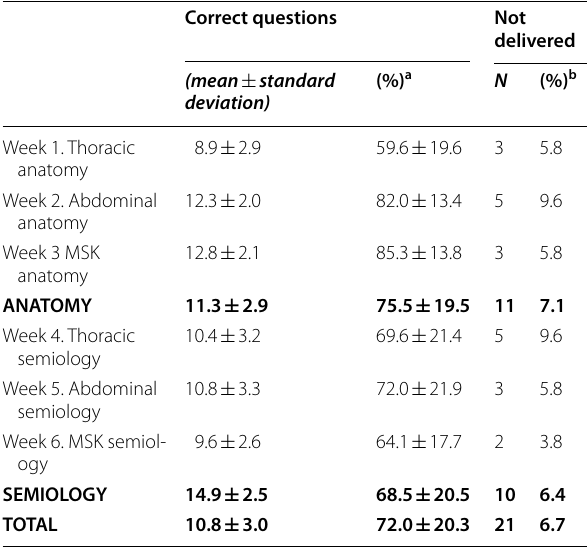
Table 2 Correct questions in the tests each week (mean standard deviation) during the game, together with the ± number of tests not delivered